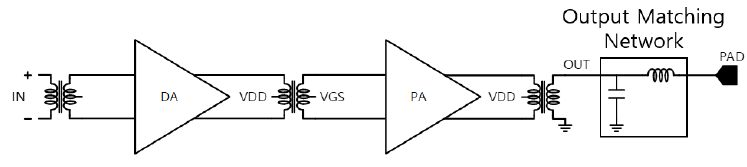
Figure 8. PA and Drive Amplifier (DA) block diagram.